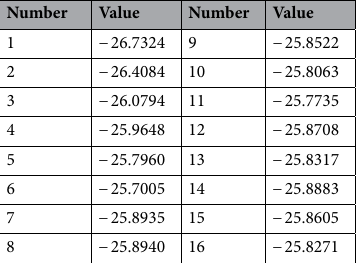
Table 10. Comprehensive